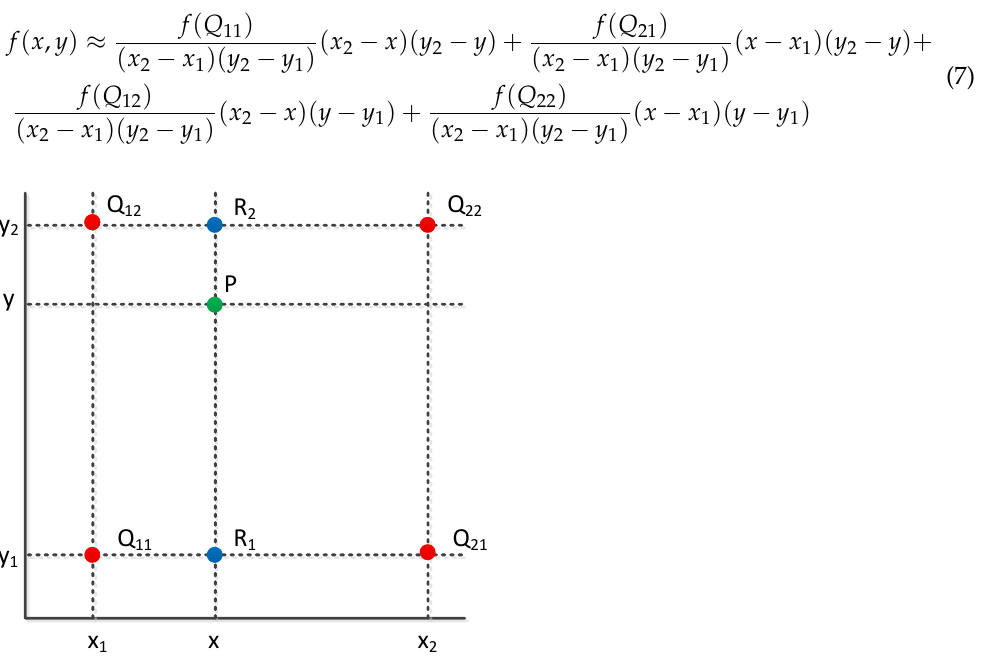
Figure 4. Bilinear